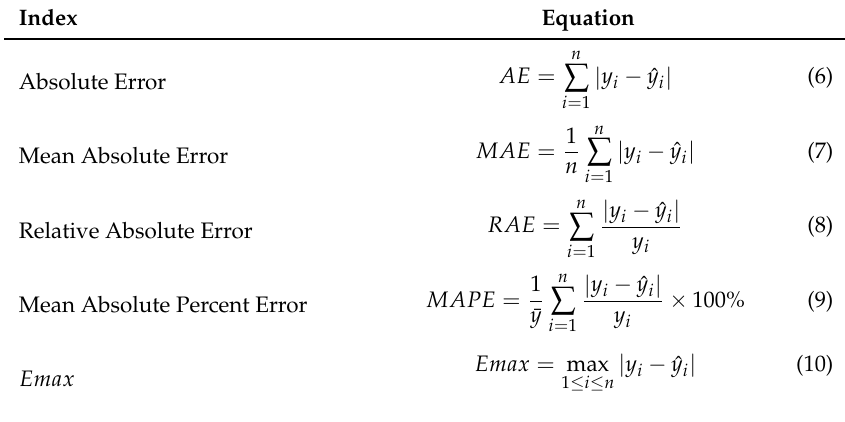
Table 2. Absolute error